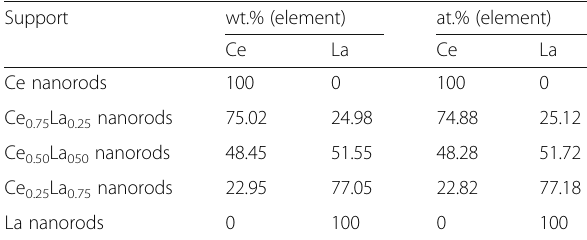
Table 3 EDS results of Ce-La nanorods with different La